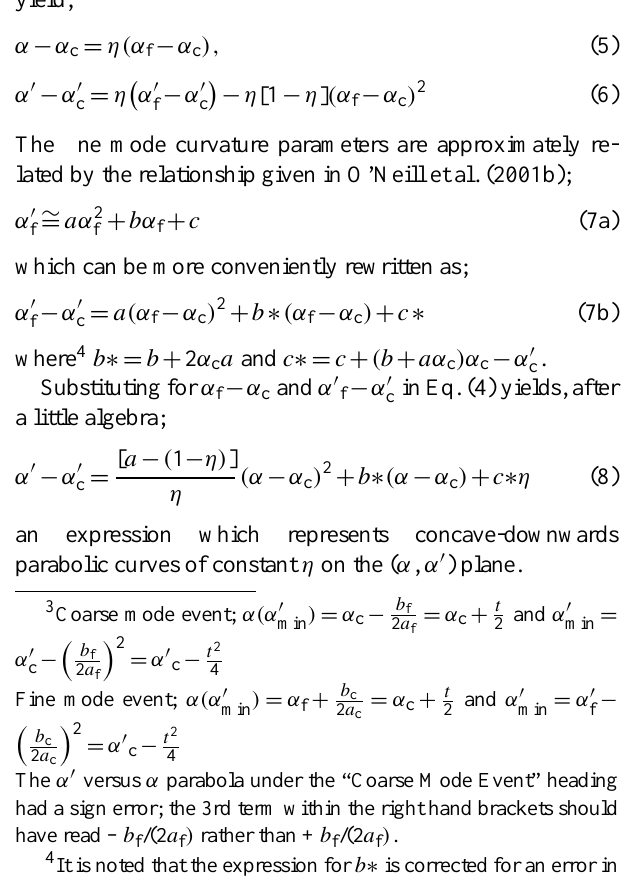
This figure is analogous to the empirical δα vs α figures presented in Gobbi et al. (2007) except Fig. 1. Contours of constant “ t ” (black curves) and η (grey curves) that their axes represent variables that are discrete rather than differentially continuous and our α ' superimposed on an ( α , α 0 ) grid (reference wavelength of 500nm). is taken as positive if α increases with increasing wavelength ("differentially continuous" in the Some illustrative data for the coarse mode and fine mode events of sense of true derivatives applied to a spectral polynomial). The blue circles show a coarse mode 11 and 27 June 2001 at the CARTEL AERONET (AEROCAN) site event (most likely thin cloud) associated with an extensive increase in coarse mode optical depth (O’Neill et al., 2003) and a mixed fine-mode, coarse-mode event on (and relatively little variation in "t" or hence fine mode size) while the red circles show a fine 21 June 2007 at the GSFC AERONET site (red circles) are super- mode event for which "t" and thus the fine mode particle size appear to change substantially. The imposed on the non-linear ( t , η) GSFC data shows a combination of these two cases.